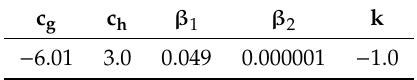
Table 3. Material of non ‐ proportional parameters used in Equation (7) .